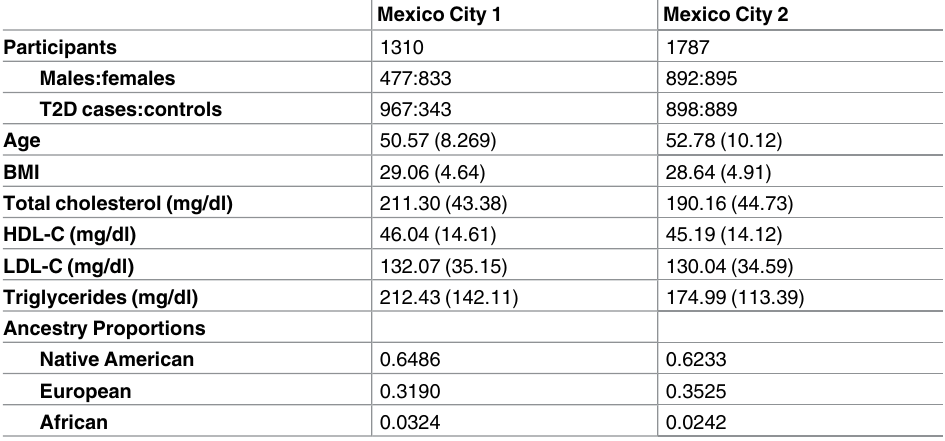
Table 1. Descriptive information of the two Mexico City samples used for admixture mapping analy- sis. Valuespresentedare averages with the standarddeviationincludedin brackets. Average lipidconcentra- tions do not reflect correction for lipid-lowering